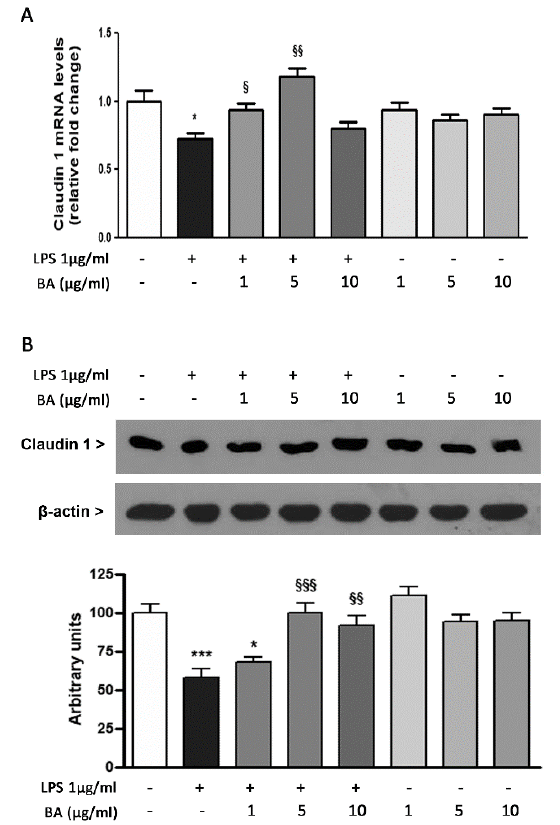
Figure 5. Effects of BA on claudin 1 gene and protein expression in HT-29 cells treated with LPS. ( A ) HT-29 cells were treated with BA that was added to culture medium 30 min before exposure to LPS for 4h. The mRNA transcript levels were analyzed by Real-Time PCR. ( B ) The expression levels of claudin 1 protein were evaluated by Western blotting. The densitometric analysis (bottom) of claudin 1 band intensities was performed after protein normalization against β -actin levels. * p < 0.05, *** p < 0.001, significant differences vs. Ctr; § p < 0.05, §§ p < 0.01, §§§ p < 0.001, significant differences vs . LPS.